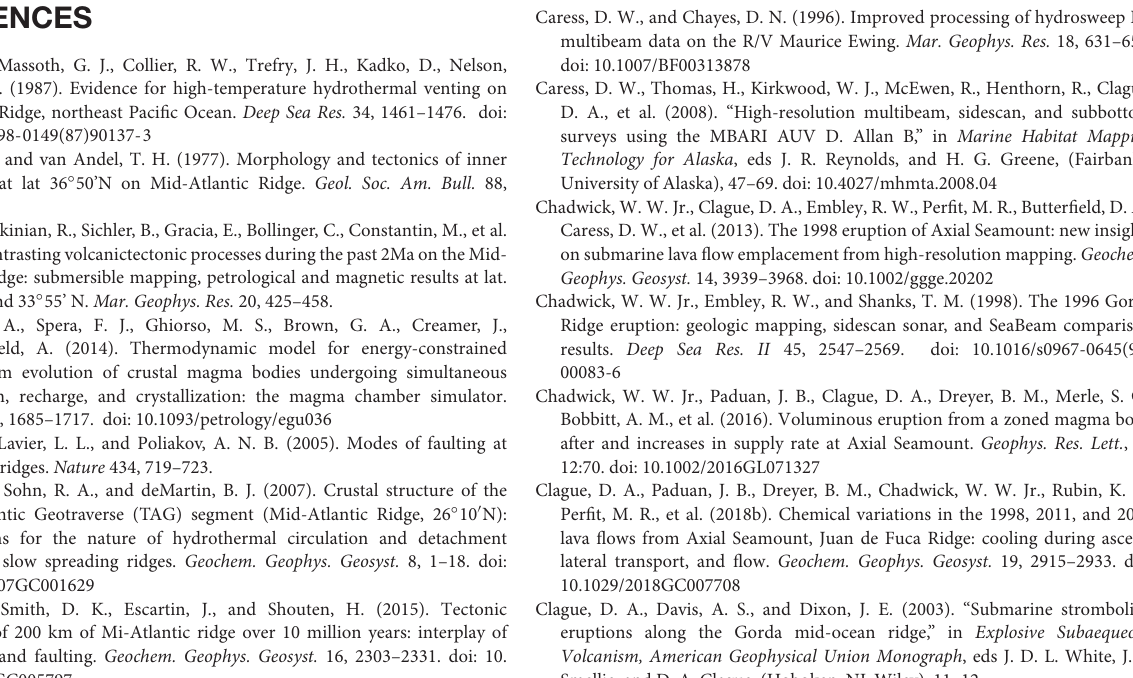
FIGURE S1 | Map of proposed southern 1996 flow (Chadwick et al., 1998) and track of ROV Tiburon dive T187 with samples coded by MgO content as in Figure 2 and the first and last rock samples labeled. The orange triangle in the SE corner is the inferred location of W9604-C2 (Rubin et al., 1998) plotted on the track of the towed camera survey. The hypothesized flow (Chadwick et al., 1998) is defined by depth anomalies (shown with maximum difference of 60 m and contour interval of 5 m) determined by difference from pre- and post-1996 bathymetric maps. It is an artifact as no young flows were encountered on T187. Color ramp is − 3550 m (dark blue) to − 3000 m (orange). FIGURE S2 | Three ridge-parallel seismic profiles collected by the AUV mounted Edgetech FS-AU sonar 2–16 kHz chirp sub-bottom profilers showing thicker sediment on distal line 2 than more proximal line 16, which has similar sediment cover to that on line 58 on the opposite side of the axis. The locations of the lines are shown in Figure 6B with line 2 from fault block Ee , line 16 from block De , and line 58 from block Cw . The maximum sediment thickness decreases from 5 to 7 m on block Ee to 2–3 m on blocks De and Cw to undetected sediment on blocks A, Bw, and Be